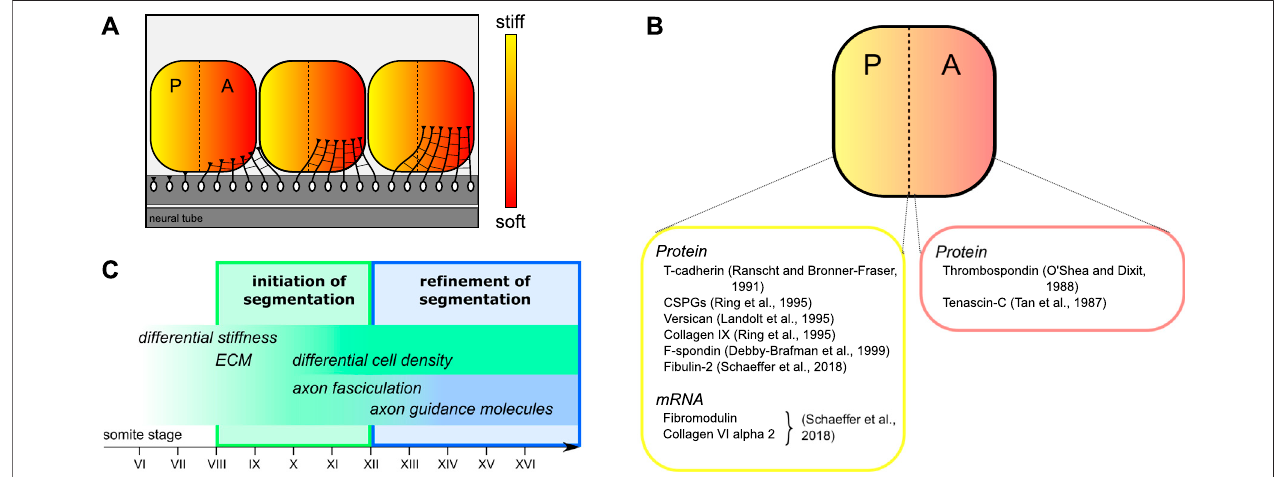
FIGURE 4 | Graphical summary of intrasegmental stiffness polarity during segmentation of motor axon outgrowth. (A) Schematic representation of motor axons growingoutoftheneuraltube.Ourresultssuggestthataxonsrespondtodifferentialstiffnessandturnintothesofteranteriorhalf-sclerotomebeforefasciculatingtoform nerve bundles. (B) Examples of ECM and ECM-associated components showing a polar distribution in the sclerotome during development. References are given for stainings by immunolabelling (Protein) and by in situ hybridization (mRNA). (C) Proposed model of initial segmentation of motor axons controlled by the periodic gradient of stiffness along the antero-posterior axis from somite stage VIII, preceding the initial motor axon outgrowth.